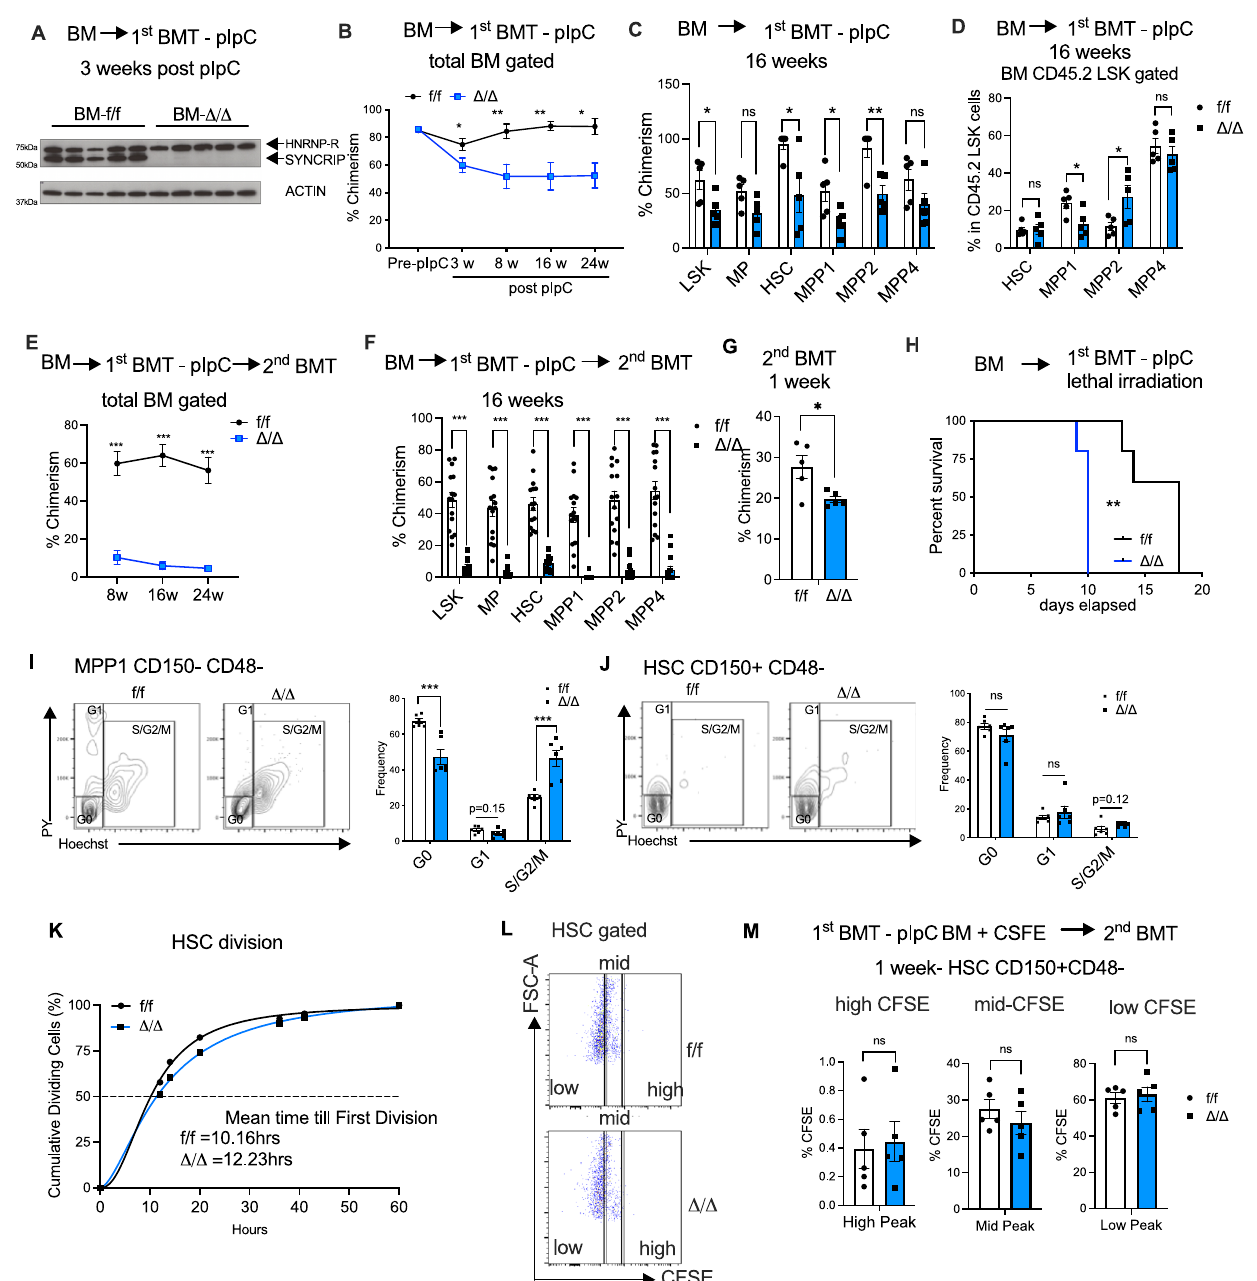
Fig. 2 | SYNCRIP plays a critical role in stress hematopoiesis. A Immunoblots showingSYNCRIPKOinengrafted Syncrip Δ / Δ BMcells3weekspostpIpCinjections. ACTINasloadingcontrol. B Chimerismofdonor-derivedBMcellsinrecipientmice described in ( A ) at: pre-pIpC, 3-( p =0.037), 8-( p =0.0059), 16-( p =0.0029) and 24- ( p =0.0041) weeks post pIpC ( n =3 donor, and n =15 recipients/genotype at pre- and 3 weeks; n =9 at 8-, 16- and 24- weeks). C Chimerism of donor-derived cells in stem/progenitorcompartmentsofrecipientmicedescribedin( A )at16weekspost pIpC. LSK ( p =0.030), MP ( p =0.051), HSC ( p =0.0254), MPP1 ( p =0.0333), MPP2 ( p =0.0058), MPP4 ( p =0.141). D Quantitative summary of frequencies of HSC and MPPs cells within CD45.2+ LSK populations of recipient mice described in ( A ) at 16 weeks post pIpC. HSC ( p =0.95), MPP1 ( p =0.024), MPP2 ( p =0.037), MPP4 ( p =0.46). E Chimerism of donor-derivedBMcellsinsecondaryrecipientsat8-,16- and 24 weeks post-transplantation. ( n =3 donor, and n =15 recipients/genotype). All p <0.000001. F Chimerism of donor-derived cells in stem/progenitor com- partments of secondary recipient mice (described in E ) at 16 weeks post-